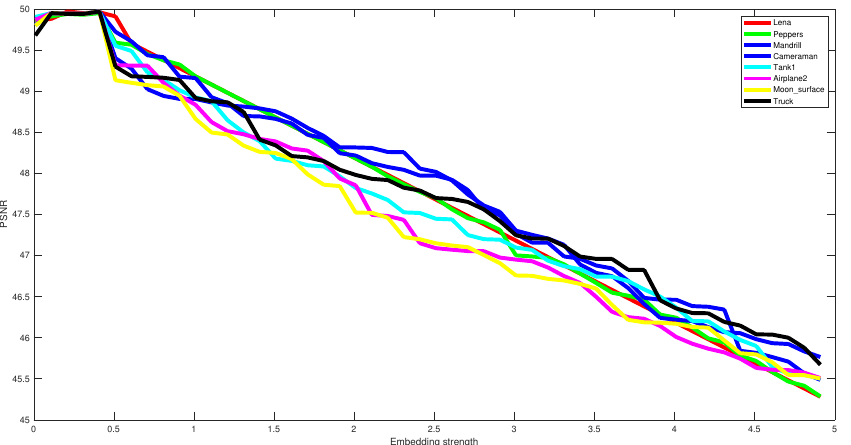
Figure 6. The obtained PSNR values using different embedding strength for several test images.